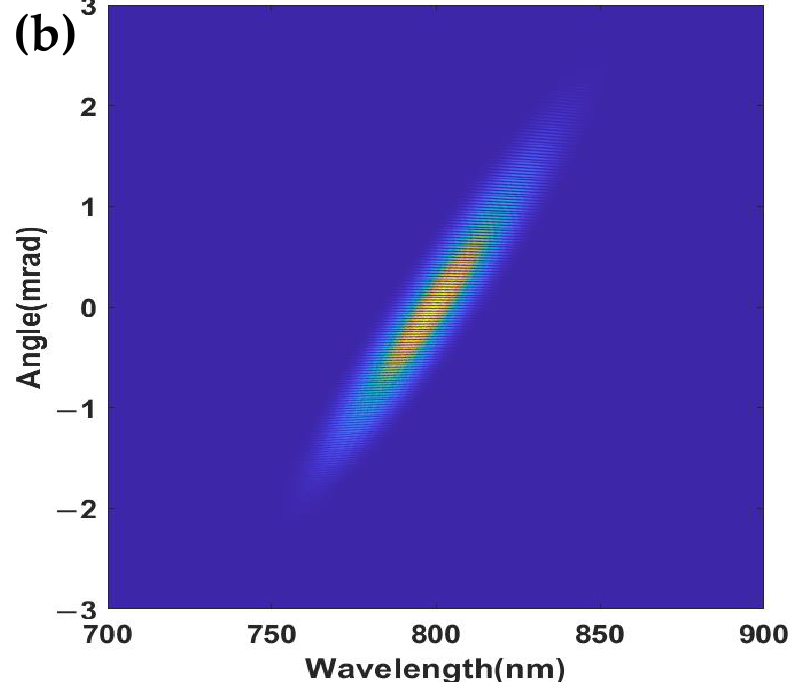
Figure 4. ( a ) Spectral profiles of the input pulse and the generated SD + 1 signal theoretically. ( b ) Relationship between the exit angle and wavelength of the SD + 1 signal by Al 2 O 3